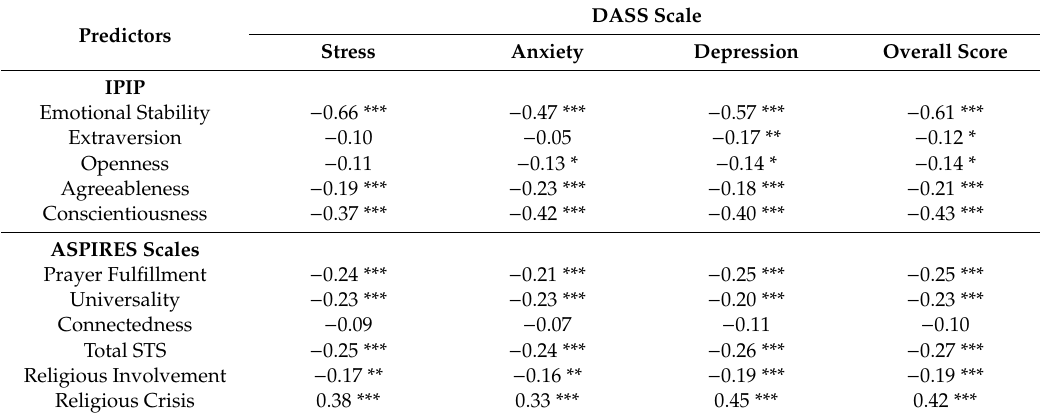
Table 2. Correlations between personality, spirituality, religious sentiments and the DASS